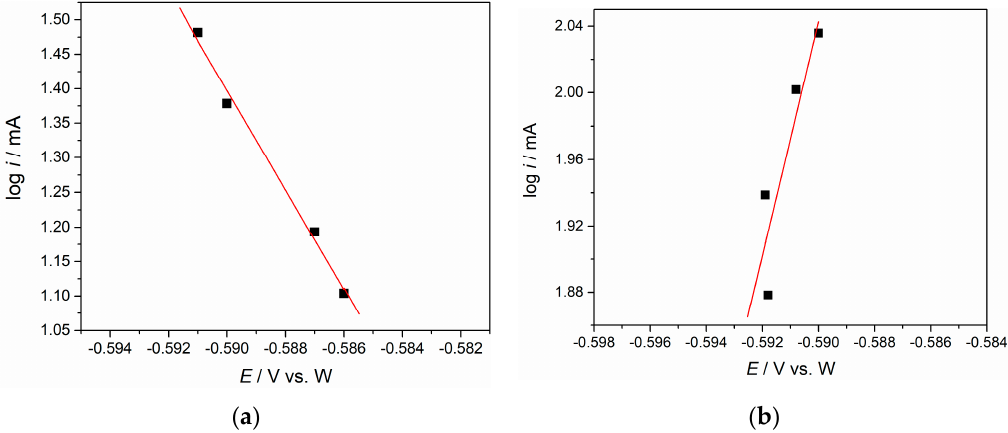
Figure 6. Logarithm of the peak current density vs. peak potential from the voltammograms in Figure 3c: ( a ) for the cathodic current wave (I); ( b ) for the anodic current wave (II’).